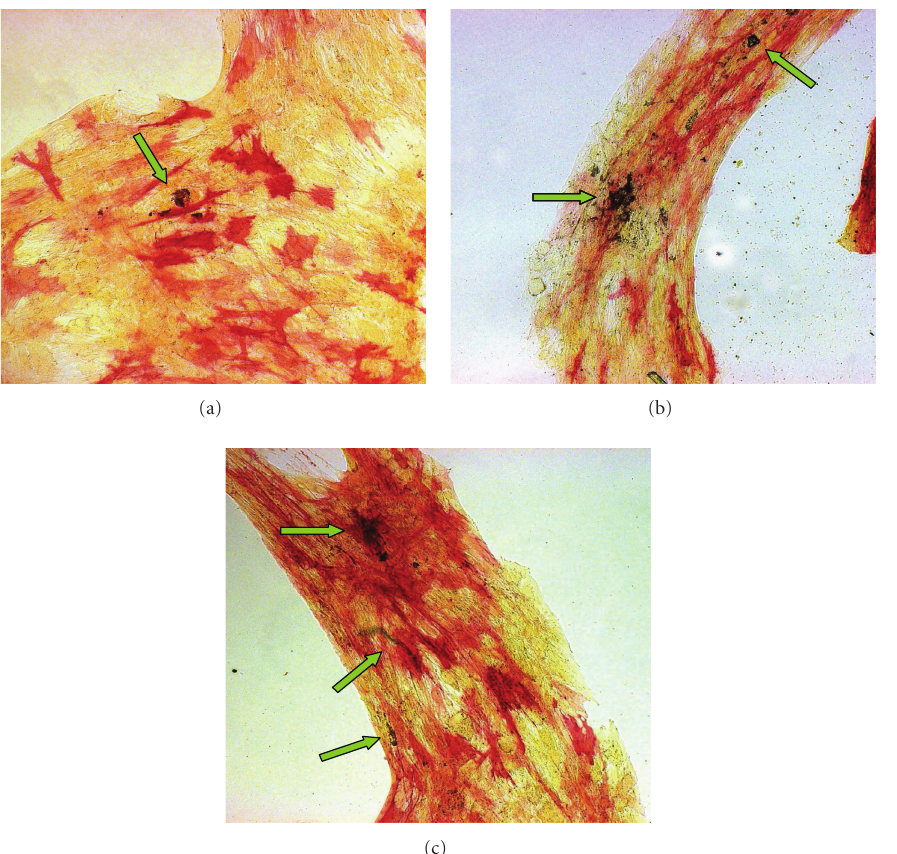
Figure 4: PA2-E12 cultured on tPS for 14 days in OM alone (a), in OM added with 30 μ M Sr 2+ (b), and without in the presence of gel- enriched with 3mM Sr 2+ (c). Cells fixed and stained for ALP. Observation in brightfield microscopy (10x objective): ALP+ cells intensity in red, ALP − cells in yellow, and HA deposits in black (green